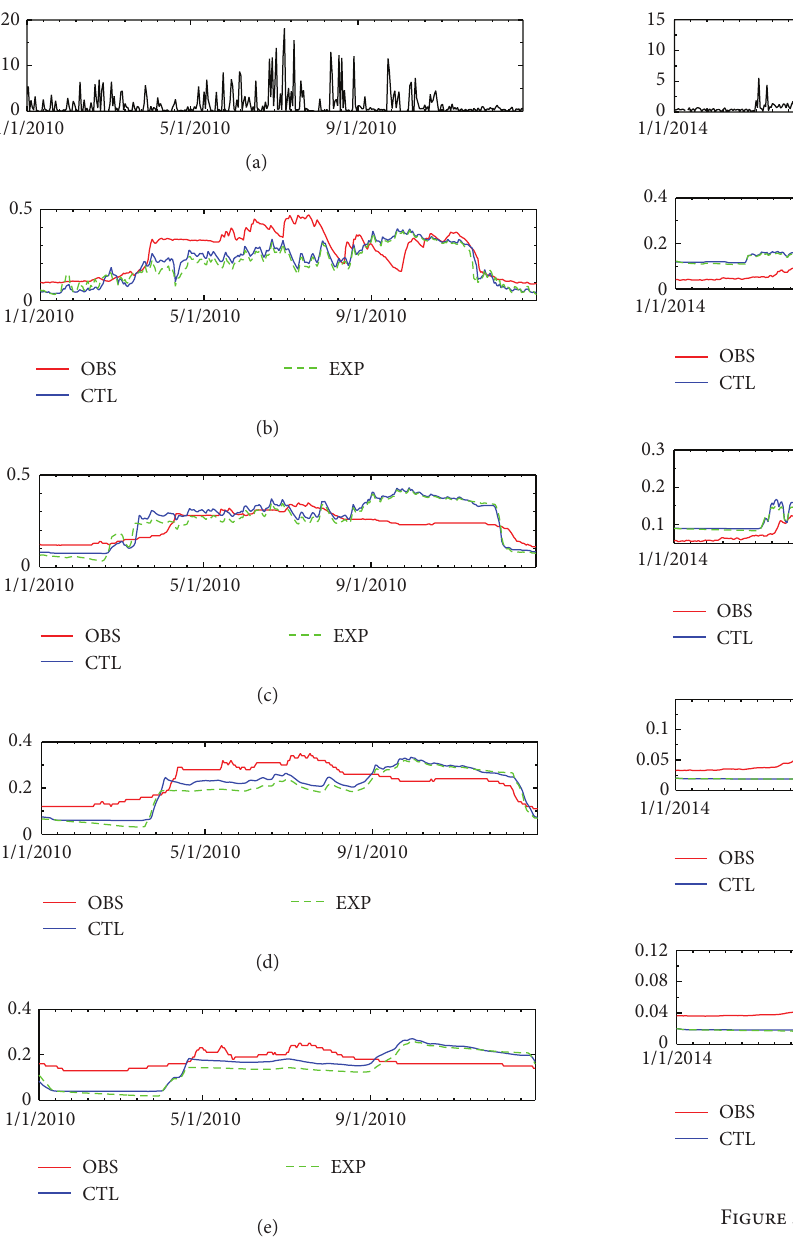
Figure 4: Daily average precipitation (mmday −1 ) (a) and soil moisture (m 3 m −3 ) at (b) 5cm, (c) 20 cm, (d) 40cm, and (e) 80cm at ZS site.